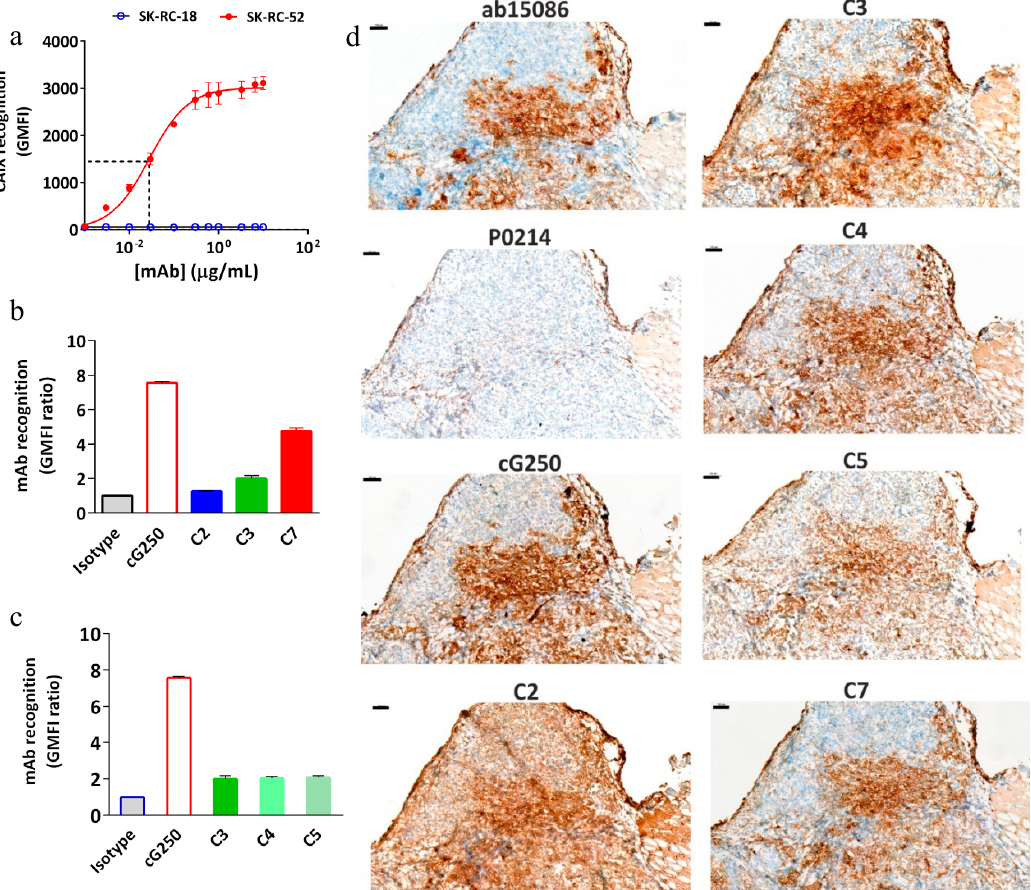
Figure 3. Immunoreactivity of DOTA(SCN)-cG250 conjugates with SK-RC-52 cells in vitro and in tumor tissue. ( a ) Concentration-dependent binding of native cG250 to SK-RC-52 cells and SK-RC-18 (control), as assessed by flow cytometry. The red dashed line corresponds to the IC50. ( b ) Flow cytometric assessment of CAIX recognition on SK-RC-52 cells of immunoconjugates C2 (90 min), C3 (60 min) and C7 (30 min). ( c ) Flow cytometric assessment of CAIX recognition on SK-RC-52 cells of immunoconjugates C3, C4, and C5 (60 min). ( d ) CAIX immunostaining in frozen SK-RC-52 tumor samples using native cG250 mAb and immunoconjugates C2, C3, C4, C5, and C7. CAIX Abcam (ab15086) as a positive control and Dako (P0214) as a negative control. 100 µ m scale bar and 10X objective.